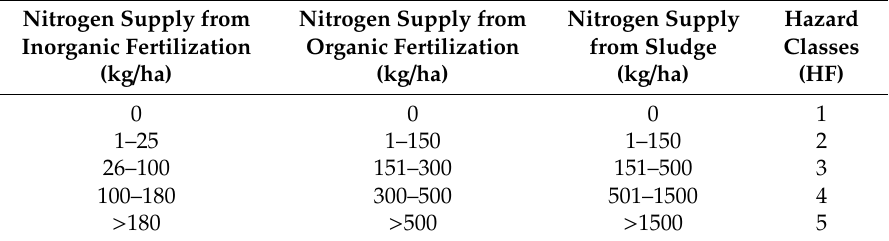
Table 1. Nitrogen supply from di ff erent fertilization types and relative hazard classes [26].